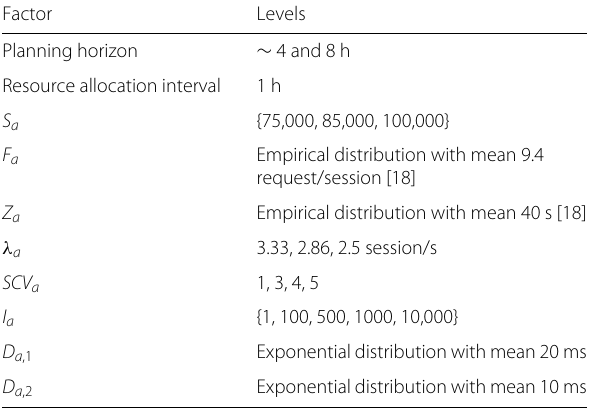
Table 3 Experiment factors and